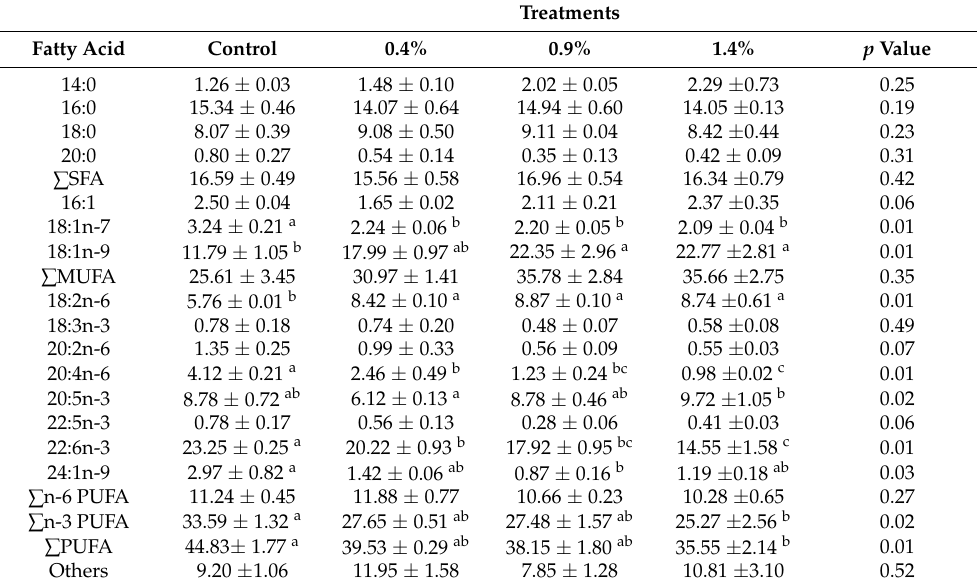
Table 6. Muscle fatty acid composition (% of total FA) of S. dorsalis juvenile fed with different ARA